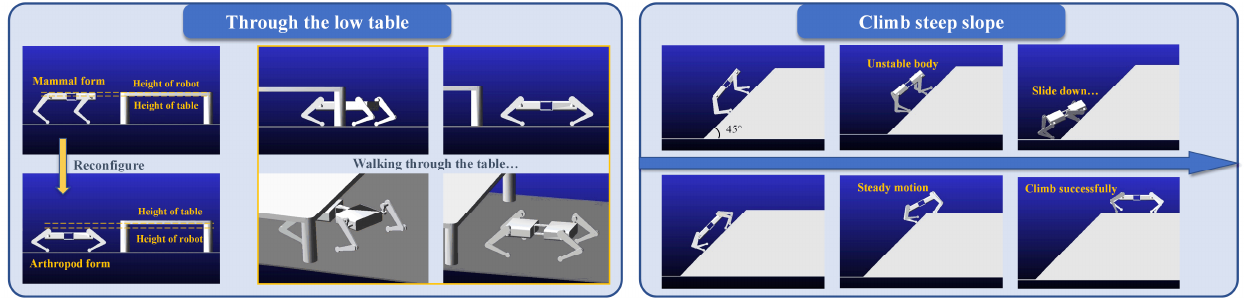
Figure 15. Simulation of two scenarios.